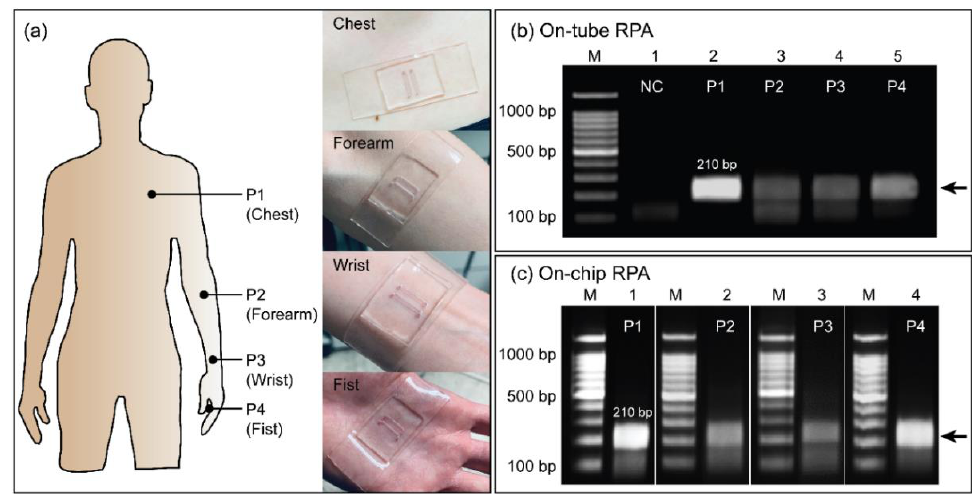
Figure 5. Wearable PDMS microdevice for RPA assays was performed using human body heat. ( a ) Illustration of four different positions (P1 — chest; P2 — forearm; P3 — wrist; and P4 — fist) and real photographs of the wearable PDMS microdevice adhered on a volunteer’s skin which was utilized to perform RPA using human body heat. ( b ) Agarose gel electrophoresis of tube-based RPA assays using human body heat at four different positions (P1 to P4). ( c ) Agarose gel electrophoresis of the wearable PDMS microdevice-based RPA assays using human body heat at four different positions (P1 to P4).